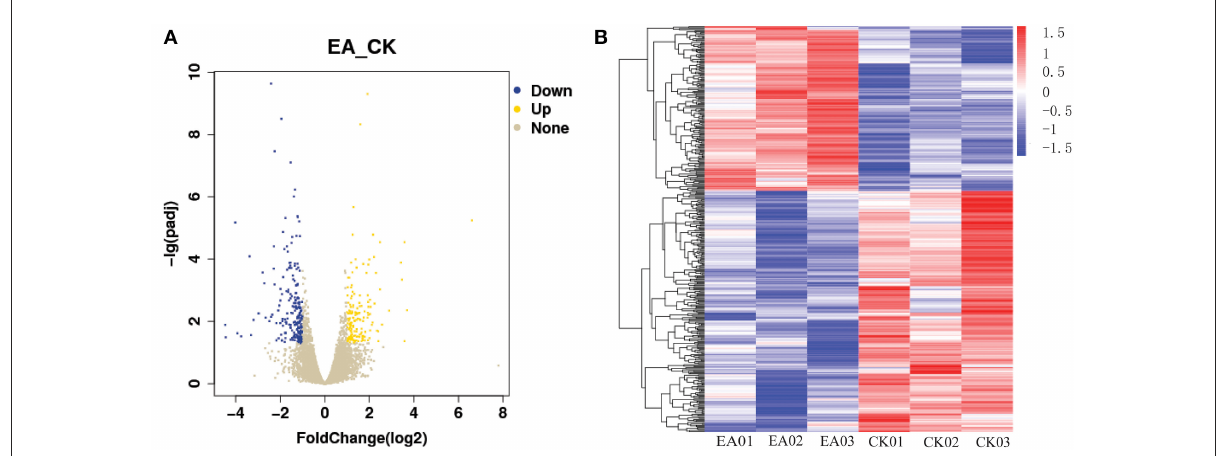
FIGURE1 The differentially expressed gene map. (A) Is the volcano map of differentially expressed gene, (B) is the heatmap of differentially expressed gene.